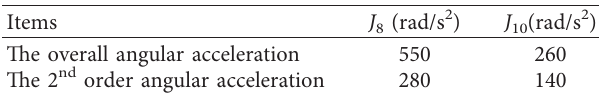
Figure 28: The 2 nd order angular acceleration curves of the primary flywheel and the input shaft of the gearbox matching the DMF under the idling condition. Table 6: Angular acceleration amplitudes under the idling con- dition for the powertrain with the DMF.